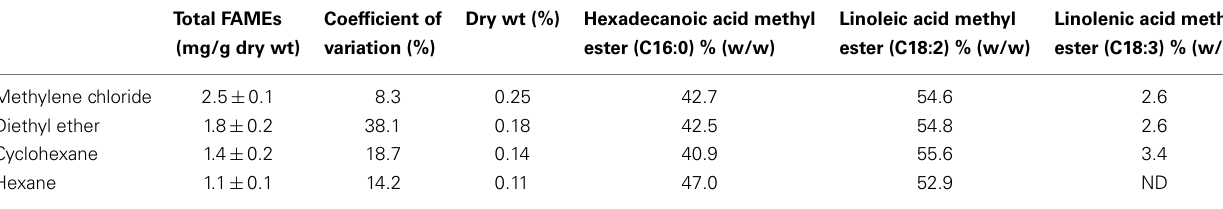
Table 2 | Summary of FAMEs from Oocystis sp. extracted with the four solvents .